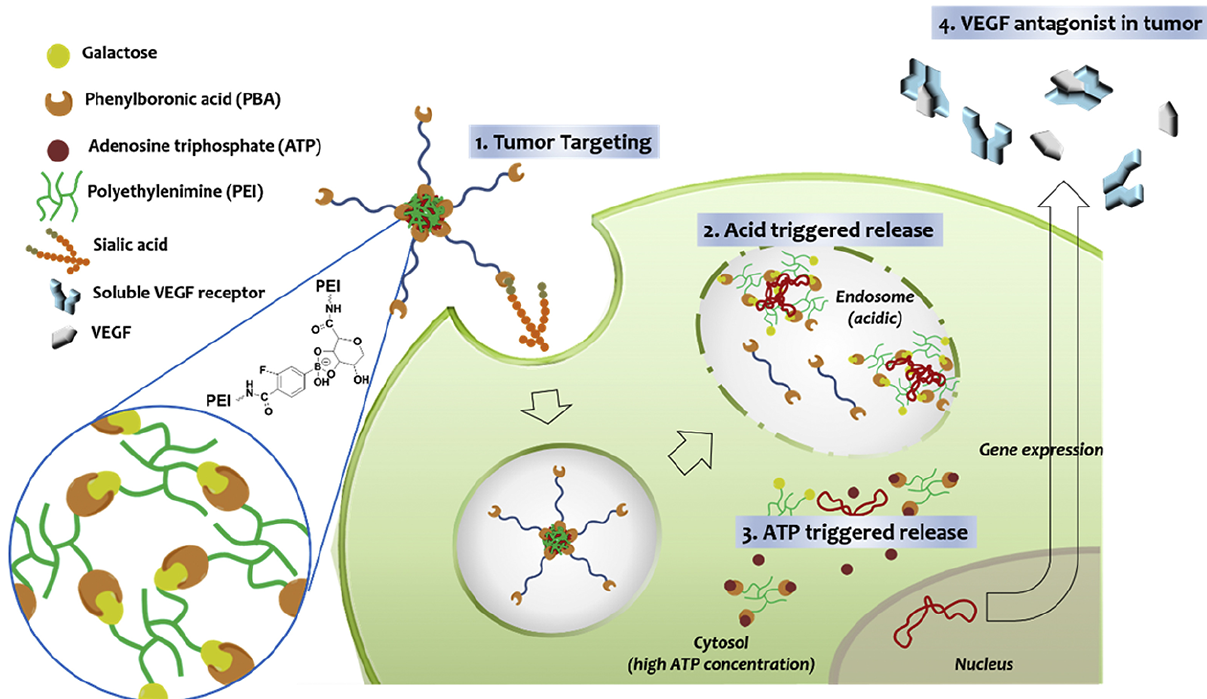
Figure 18: Schematic illustration of anti-angiogenic gene delivery mediated by PBA-PEG-Cross PEI vector. Reprinted with permission from [69]. Copyright 2015,